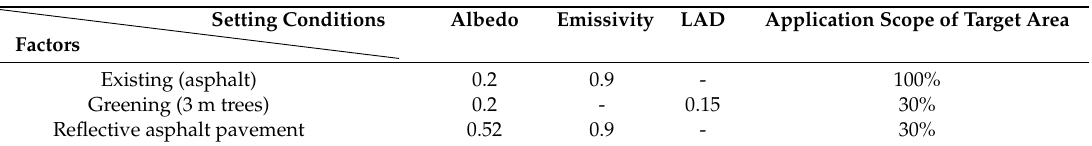
Table 8. Outline of heat island mitigation factors.